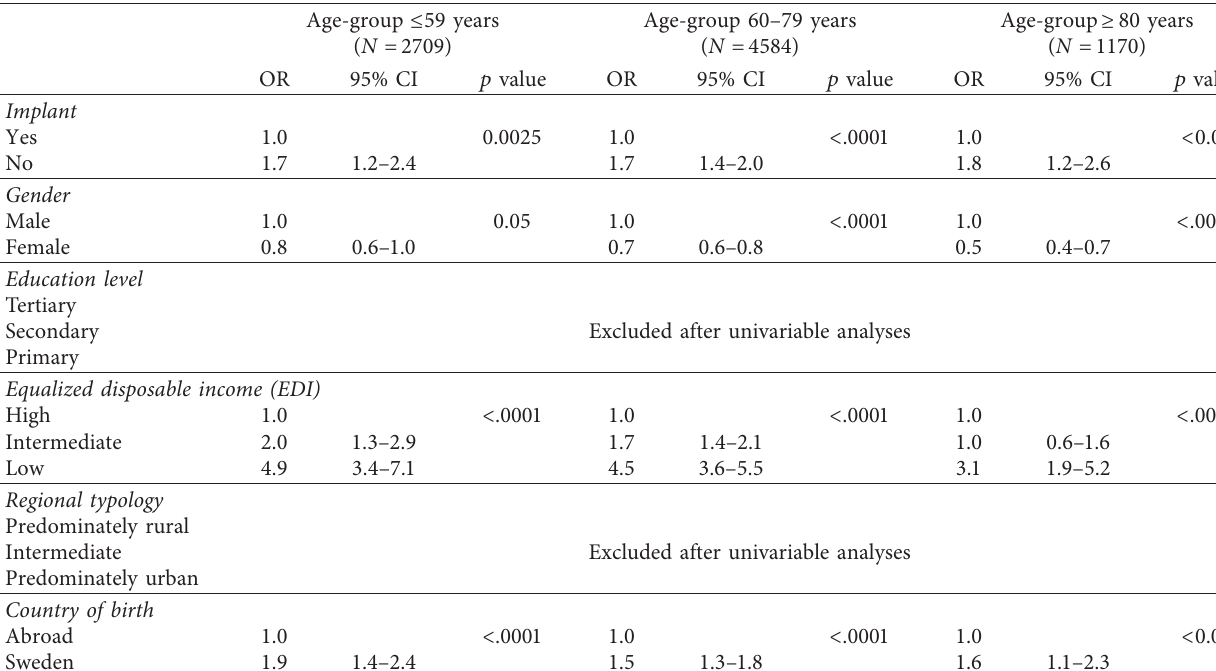
Table 2: Multivariable logistic analysis of edentulous patients stratified on